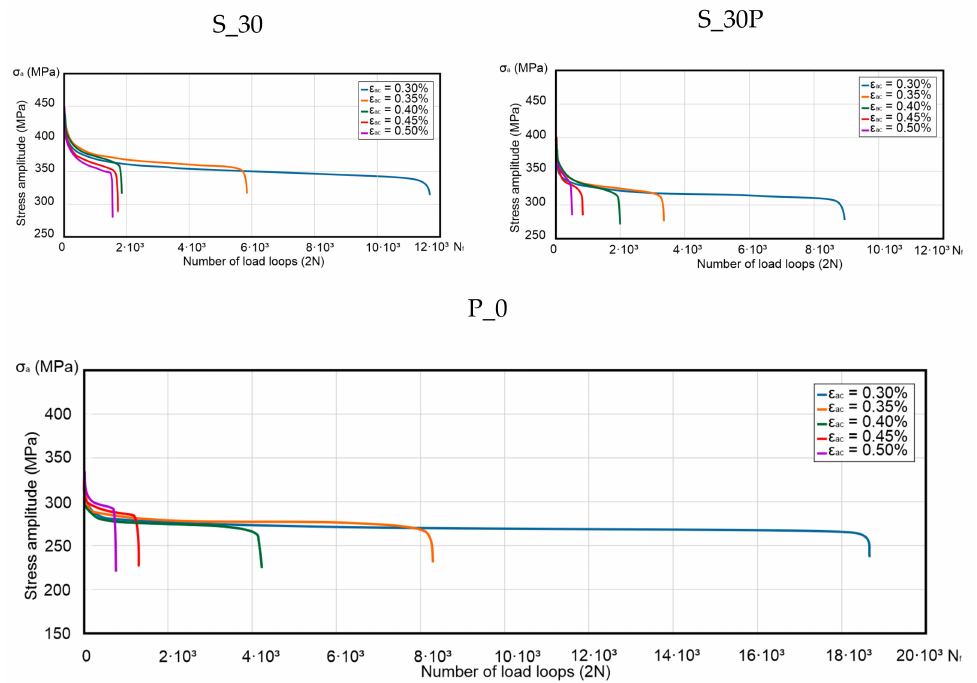
Figure 3. Variation of stress amplitude σ a with the number of cycles for additively manufactured (AM), AM heat-treated parts and conventionally made